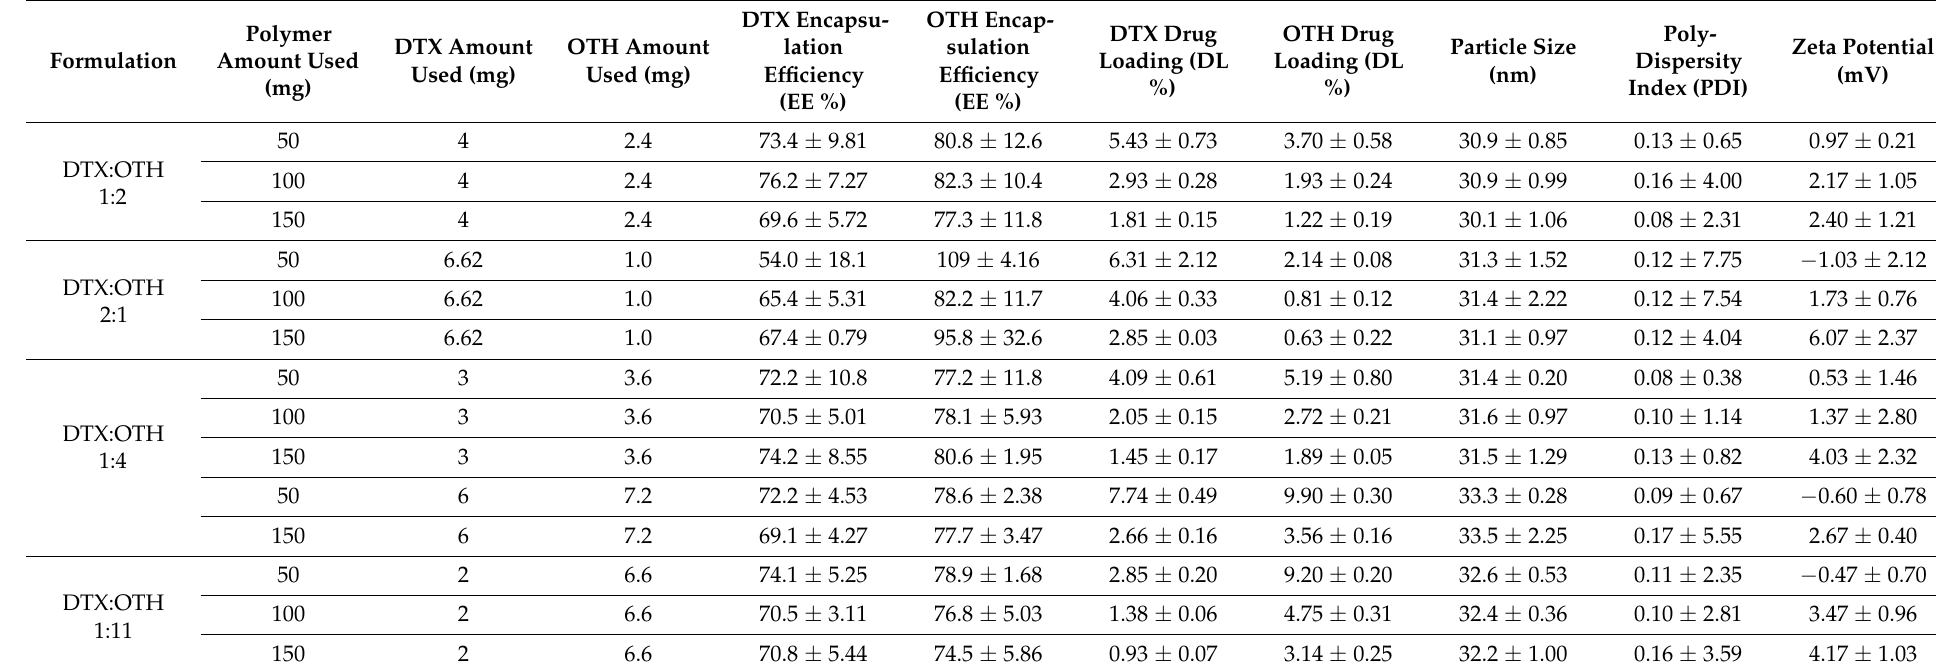
Table 2. Characteristics of docetaxel (DTX) and osthol (OTH)-loaded mPEG- b -PCL micelles ( n = 3, mean ± SD).